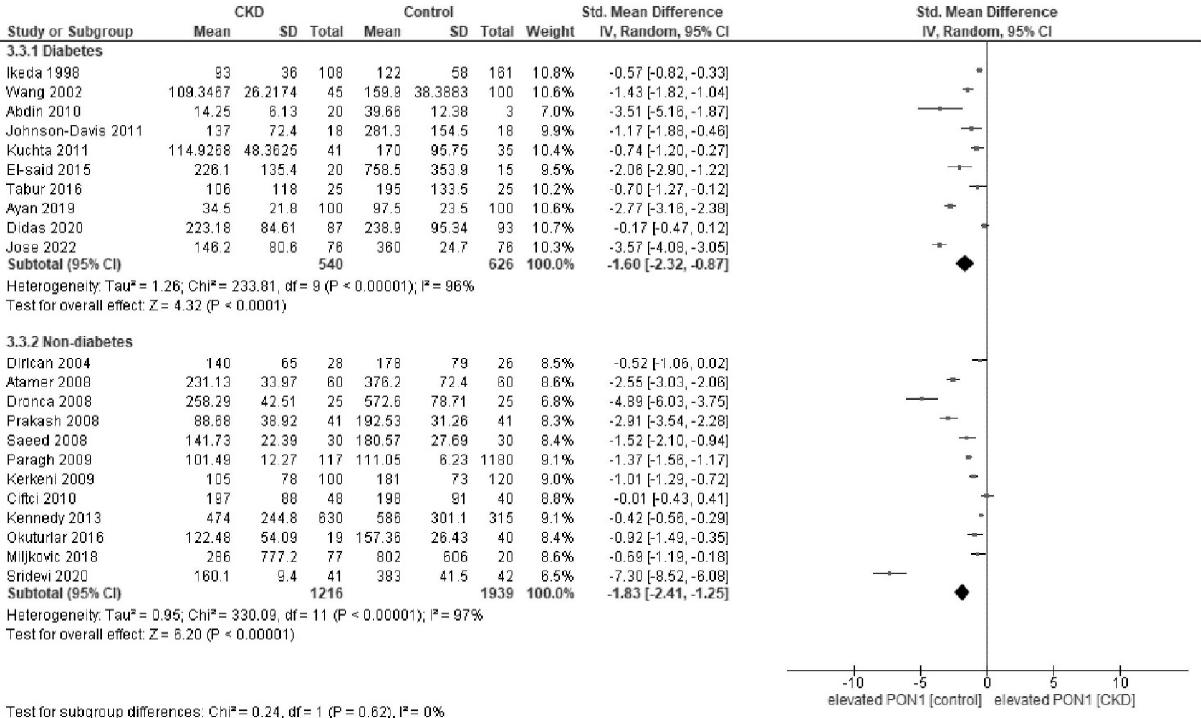
Figure A1. Details of risk of bias assessment [26–49].